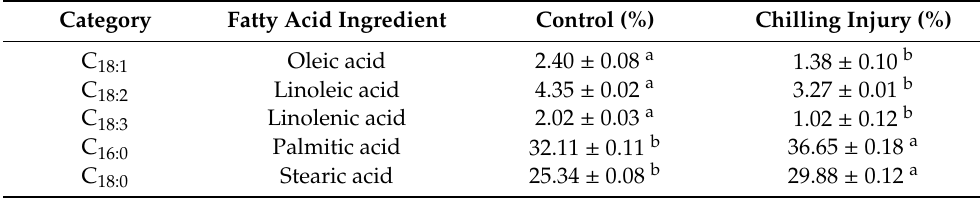
Table 2. Ingredients and relative contents of fatty acids of membrane lipids in peel of bananas stored for 0 and 4 d at 6 °C. The data are presented as means ± standard errors ( n = 3). The means with different letters are significantly different ( p < 0.05).